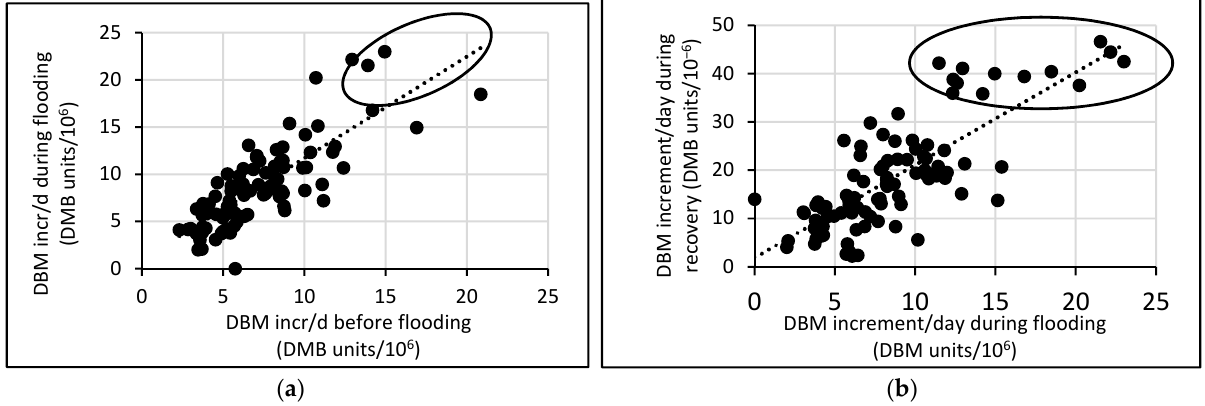
Figure 5. ( a ) Biomass increase under flooding in relation to the increase before flooding. Relative tolerant accessions are circled; ( b ) biomass increase per day during recovery in relation to the increase during flooding. Accessions with good recovery are circled. The accessions with the highest biomass during flooding and recovery related to before flooding are listed in Table 2.